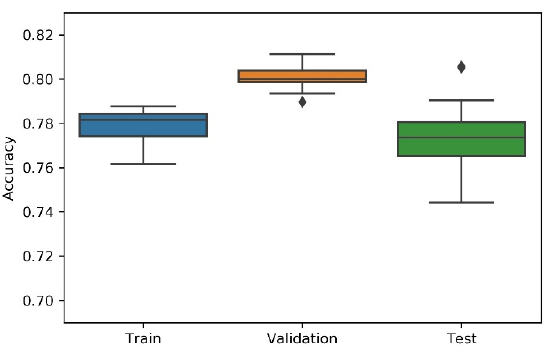
Figure 7. Experiment’s performance for Approach A1 (Greedy) accuracy (in %).